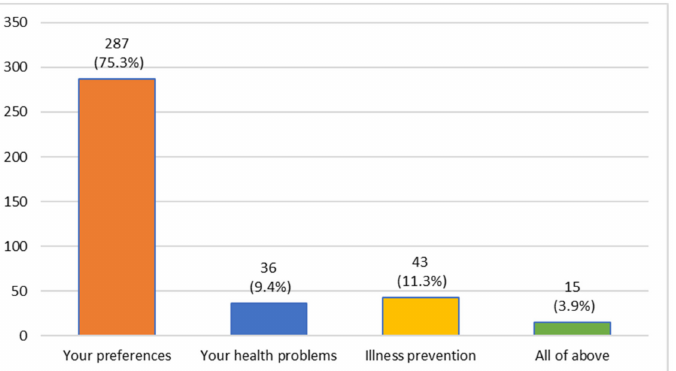
Figure 12. Distribution of the answers given by children regarding food